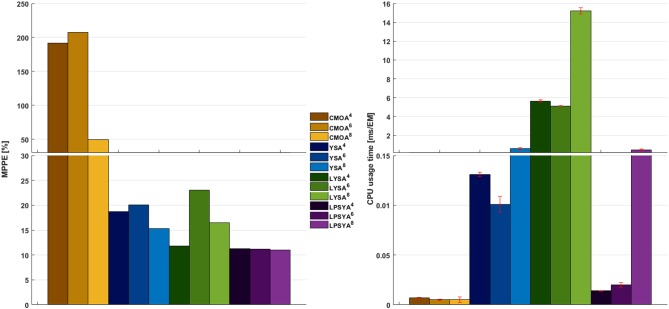
MPPE and CPU usage time over EM analyzed for the best CMOA, YSA, LYSA, and LPSYA exponential growth phase dynamic models, numerical sub-index indicates for the 4-,6-, or 8-contraint systems.